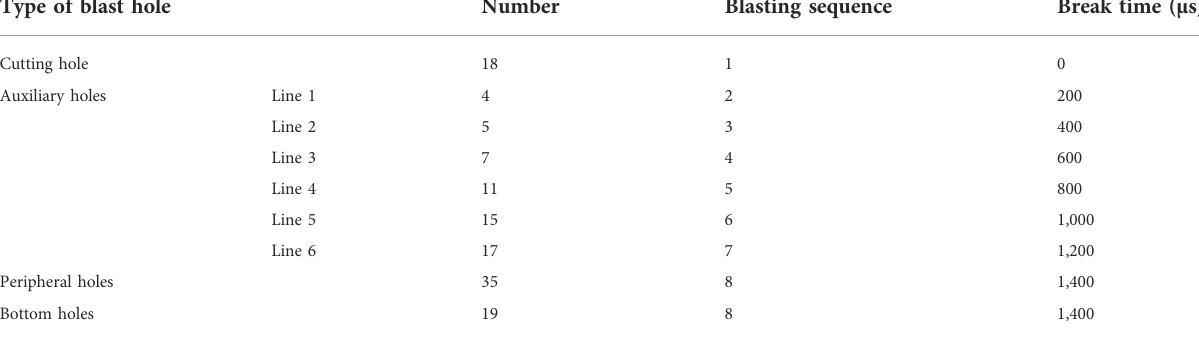
TABLE 5 Blasting parameters of the original